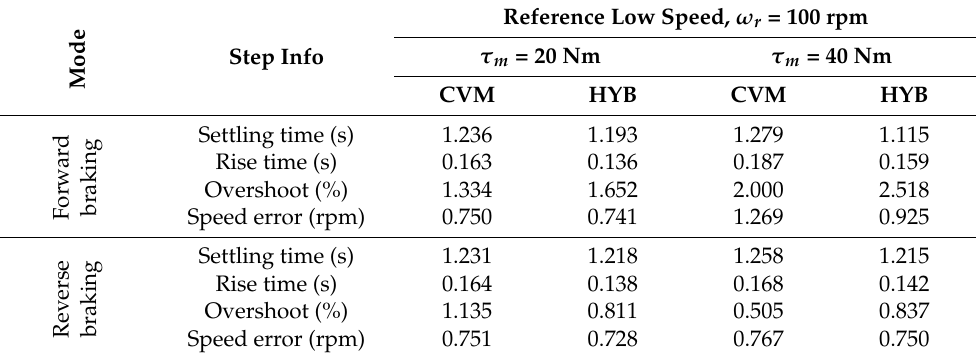
Figure 17. Rotor speed response at very low speed in regenerative braking: ( a ) in forward operation and ( b ) in reverse operation. Table 6. Rotor speed performance at very low speed in regenerative braking.